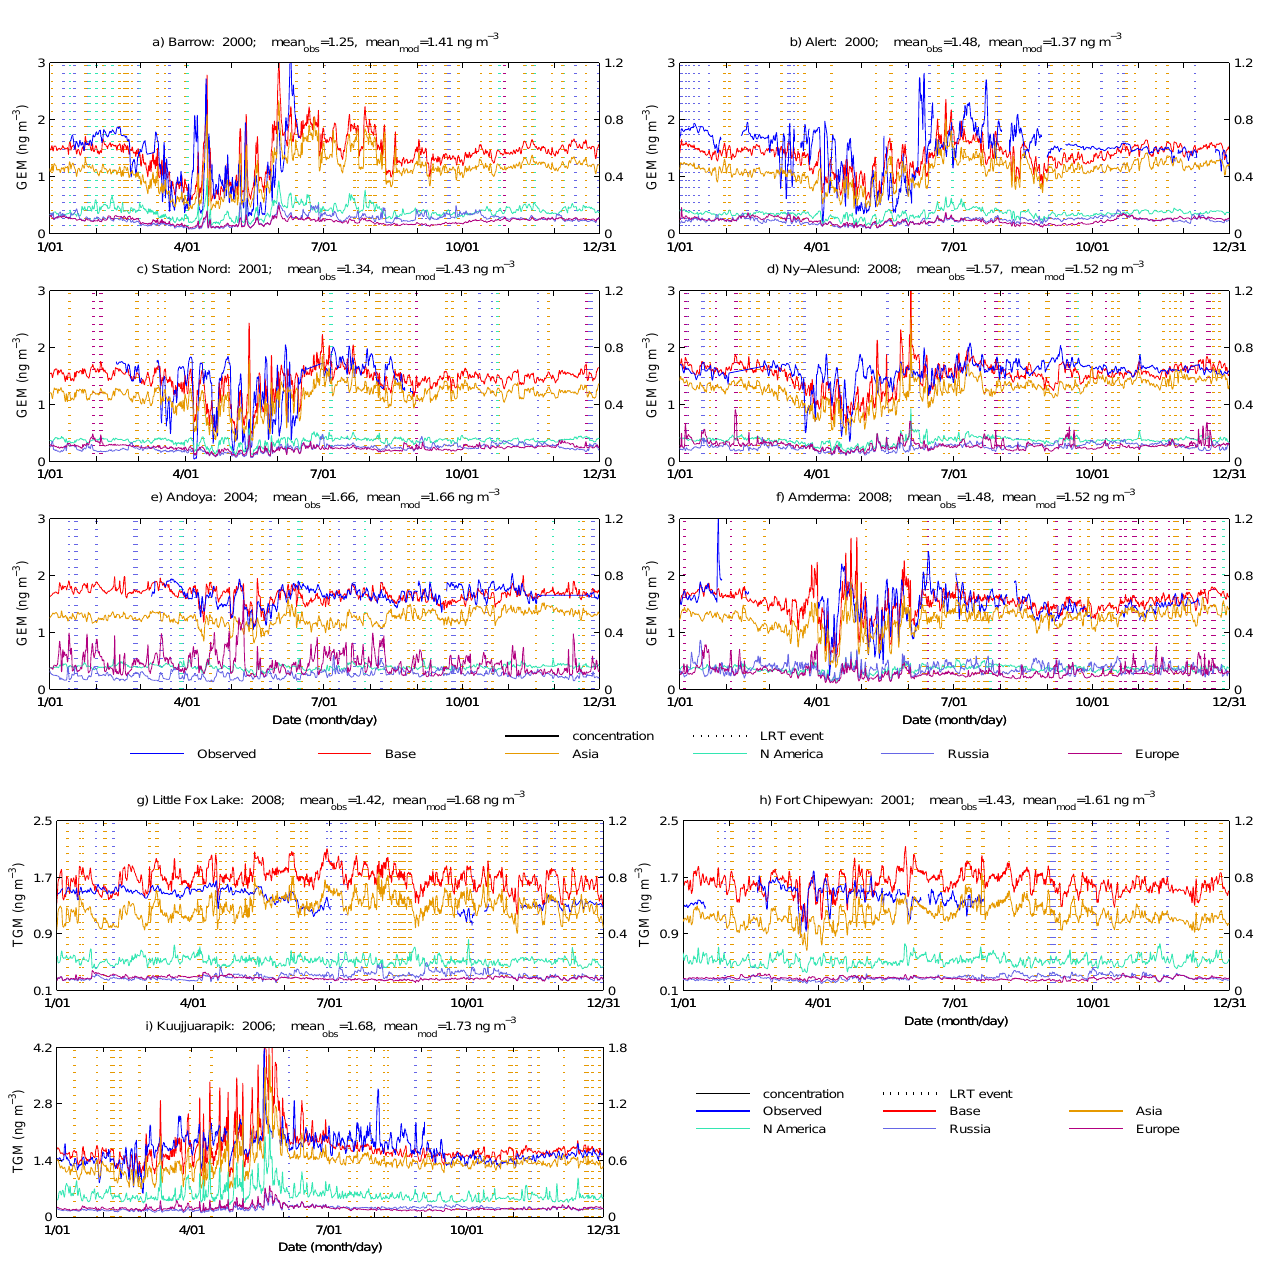
Fig. 3. Ambient surface-level GEM or TGM concentrations as observed at each verification station for the year indicated, and as simulated using emissions from the indicated source regions. The right hand axis pertains to observations and the base run. The left hand axis pertains to the simulations using emissions from only one of the four source regions. Note that axis limits are constant for panels (a–f) and (j–q) , but that those of panel (i) differ from those of panels (g–h) . Vertical dashed lines indicate LRT events. Stations from each station group are arranged from west to